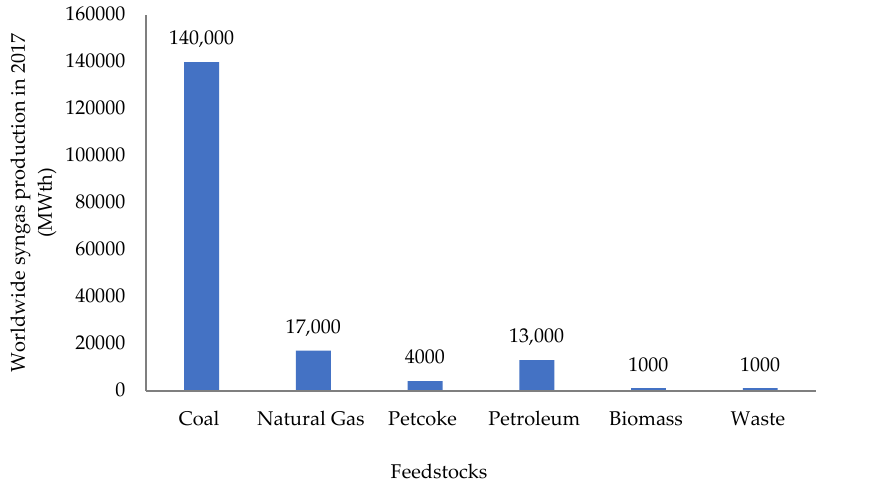
Figure 8. Worldwide production of syngas from different feedstocks (adapted from [111]).